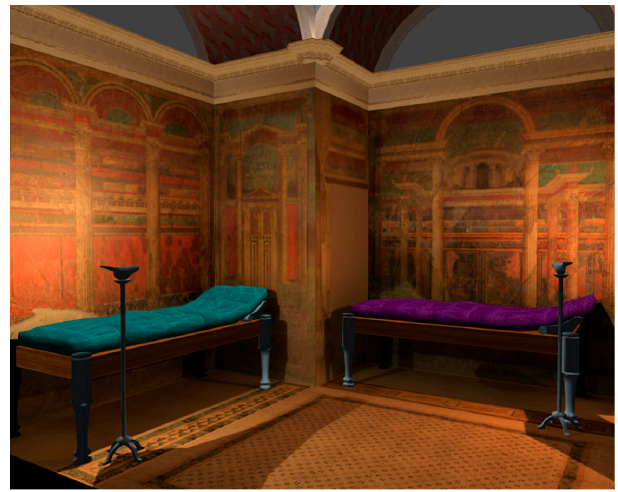
Figure 9. Digital reconstruction of Cubiculum 16, Villa of the Mysteries, Pompeii, created by Philip Stinson for the UCLA Cultural Virtual Reality Laboratory, Bernard Frischer, Director; © Copyright 2002 Regents of the University of California. All rights reserved.